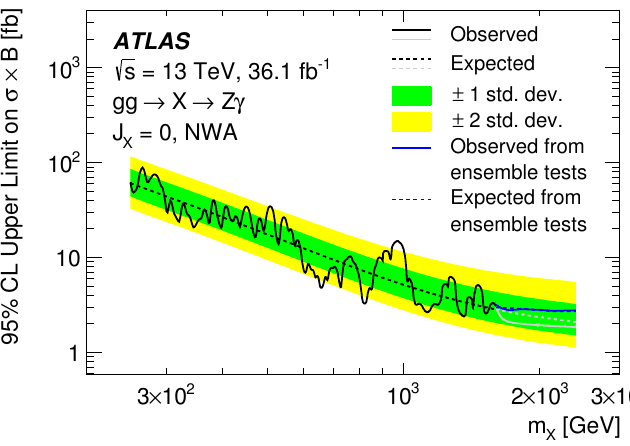
Figure 7 . The observed (solid line) and expected (dashed line) upper limit derived at the 95% p CL on (cid:27) ( pp ! X ) (cid:1) B ( X ! Z(cid:13) ) at s = 13 TeV as a function of the high-mass spin-0 resonance’s mass, assuming production via gluon-gluon fusion and using the narrow width assumption (NWA). For m X > 1 : 6 TeV results are derived from ensemble tests in addition to the results obtained using closed-form asymptotic formulae. The shaded regions correspond to the (cid:6) 1 and (cid:6) 2 standard deviation bands for the expected exclusion limit derived using asymptotic